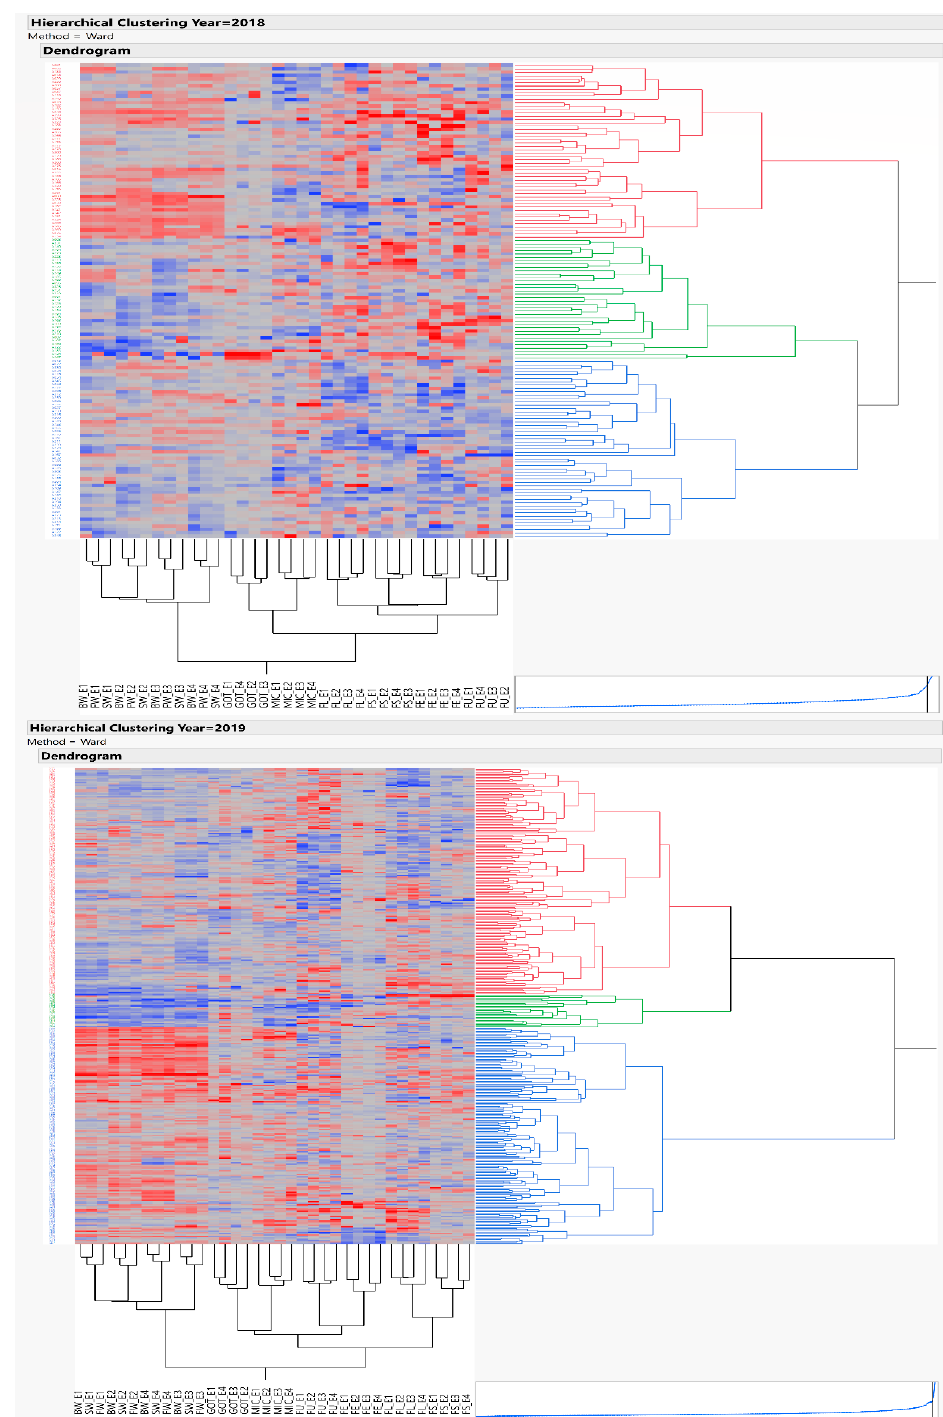
Figure 6. Hierarchical clustering of 355 upland cotton accessions for yield related and fiber quality traits based on treatment effects across years 2018 and 2019.